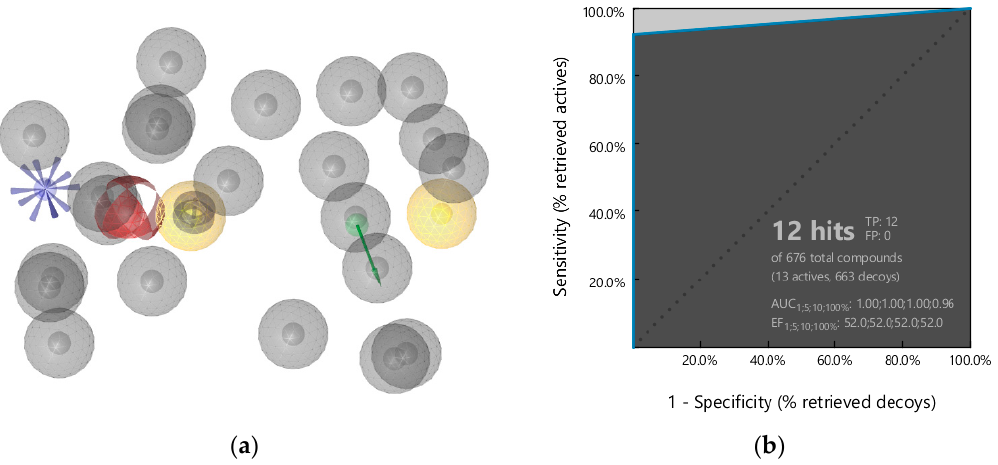
Figure 2. ( a ) Ligand-based pharmacophore model for Hsp90 CTD inhibitors. Common chemical features of the aligned molecules include 2 hydrophobic (yellow spheres), one with an aromatic feature (blue disc), a hydrogen bond (H-bond) donor (green arrow) indicating a defined direction for H-bonding, H-bond acceptor (red sphere), positive ionizable (blue star), and exclusion volumes (grey spheres) that define restricted regions based on the shape of the aligned molecules. ( b ) Resulting receiver operating (ROC) plot (curve shown in blue) from virtually screening 676 compounds (13 Hsp90 CTD actives and 663 generated decoys) with the ligand-based pharmacophore model. TP = true positives; FP = false positives; AUC = area under the curve; EF = enrichment factor.